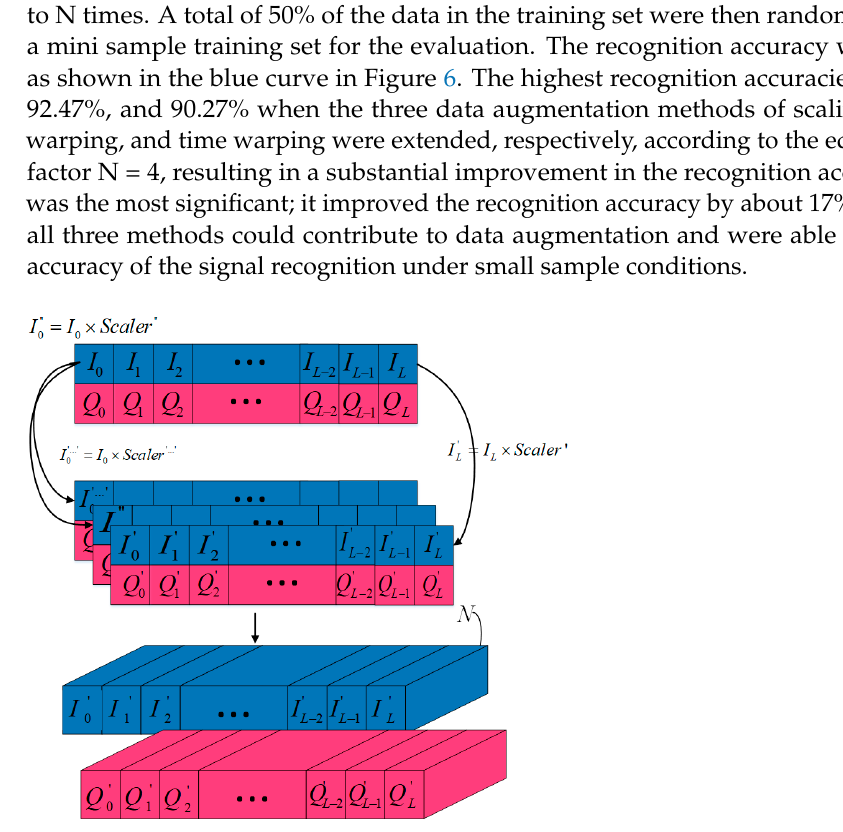
Figure 6. Recognition accuracy of three data augmentation methods under different SNRs. As DL depends on a massive volume of data, the characteristics learned at the front end of the network are entirely derived from existing data. As the amount of data used for learning increases, it is possible for the neural network to learn additional and superior characteristics by obtaining significantly greater amounts of information. Therefore, two sets of experiments were performed to examine the effect of the database size on the net- work performance by enhancing the dataset with the magnitude warping method as an example. First, 360,000 samples were randomly selected from the original dataset as the training set. The training set samples remained unchanged and different small equal scale factors were used to enhance the training set. In the second group, the original data sizes of 3600 and 36,000 were selected to be enhanced 100 times and 10 times, respectively. The corresponding relationship between the equal scale factor and the data size is shown in